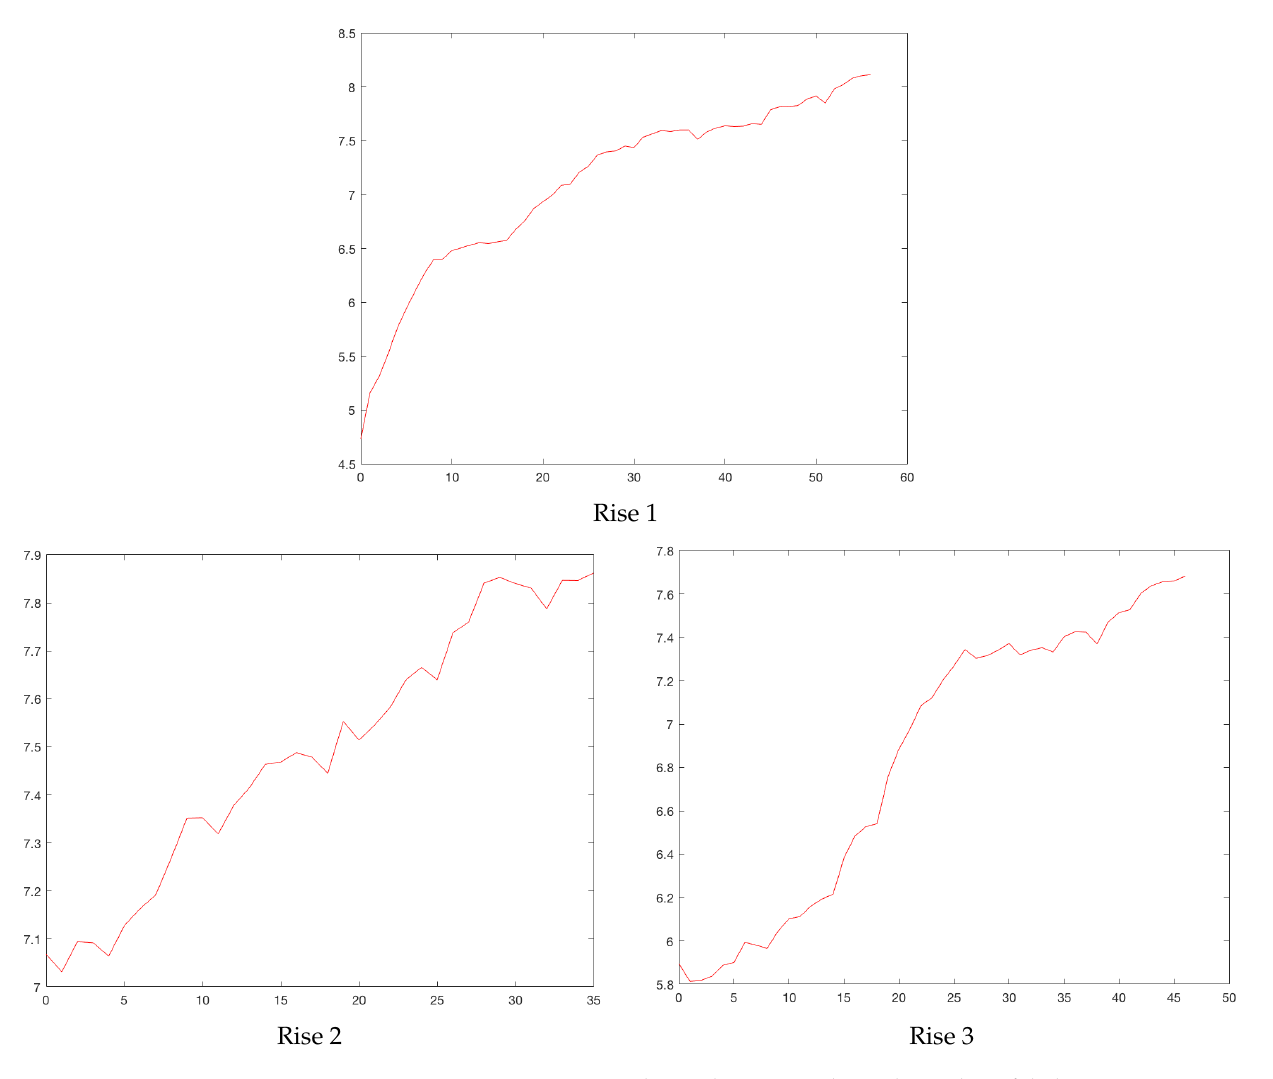
Figure A5. Lima’s rises. Horizontal axis, days; vertical axis: logarithm of daily cases.